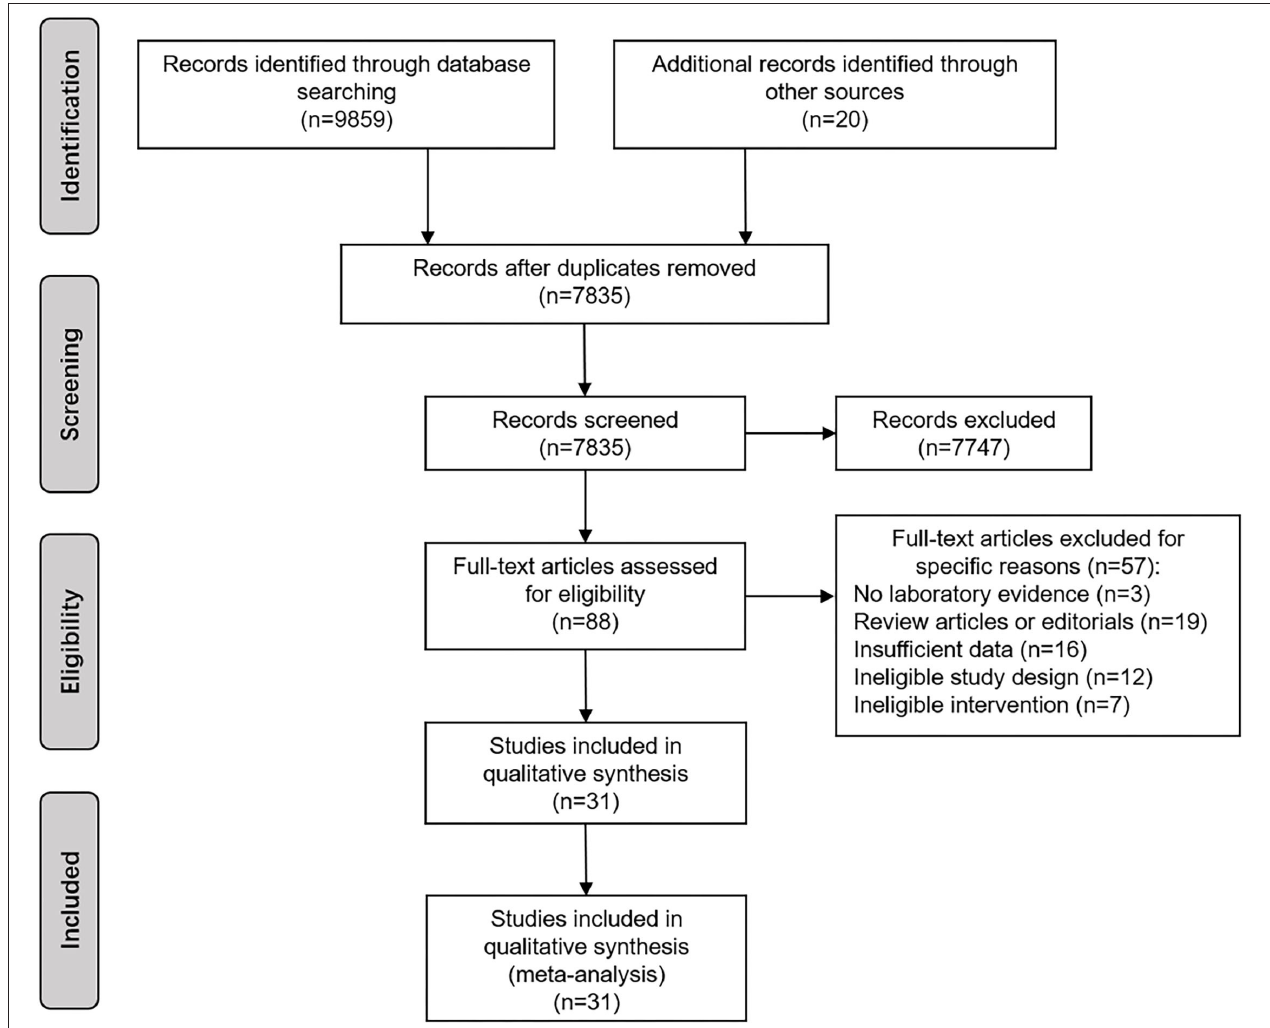
FIGURE 1 | The study selection